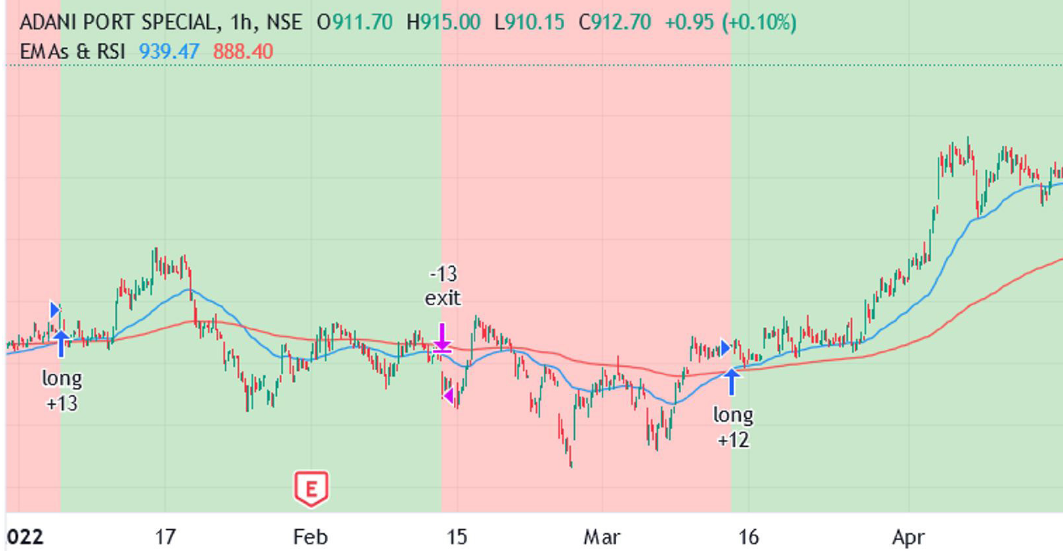
Figure 3. EMA & RSI Strategy applied on Adani Ports & SEZ Ltd.